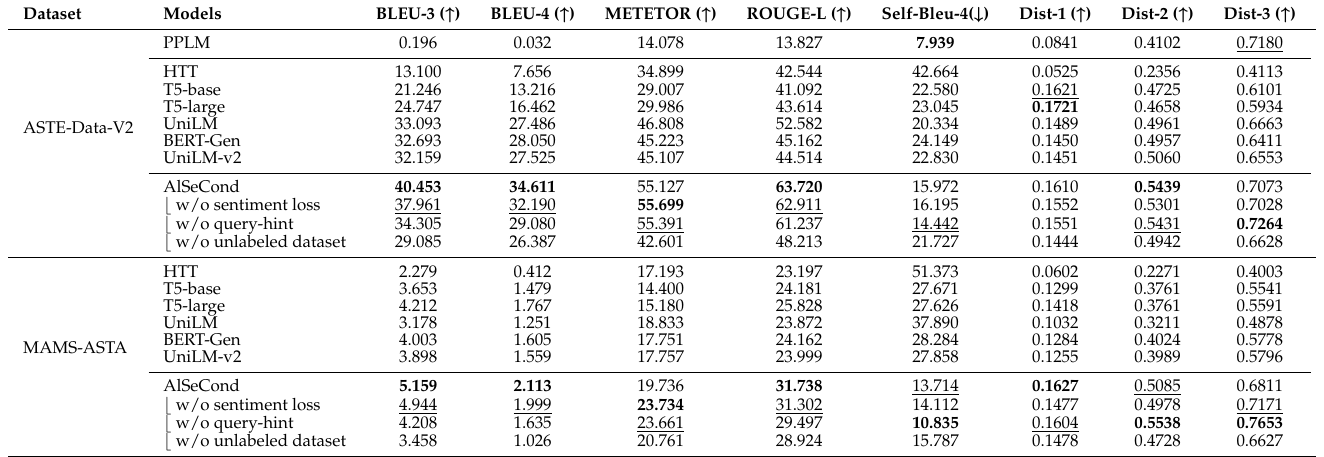
Table 2. Results for the fluency and diversity evaluation. Note that “ ↑ ” means the higher the better, “ ↓ ” means the lower the better, “w/o” means